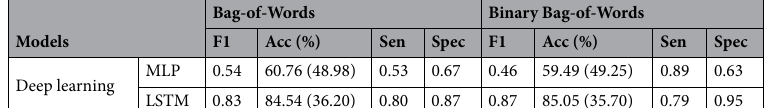
Table 9. Performance result obtained with logistic regression and SVM applied to Bag-of-Words and Binary Bag-of-Words feature representation of the validation (peptide) data.